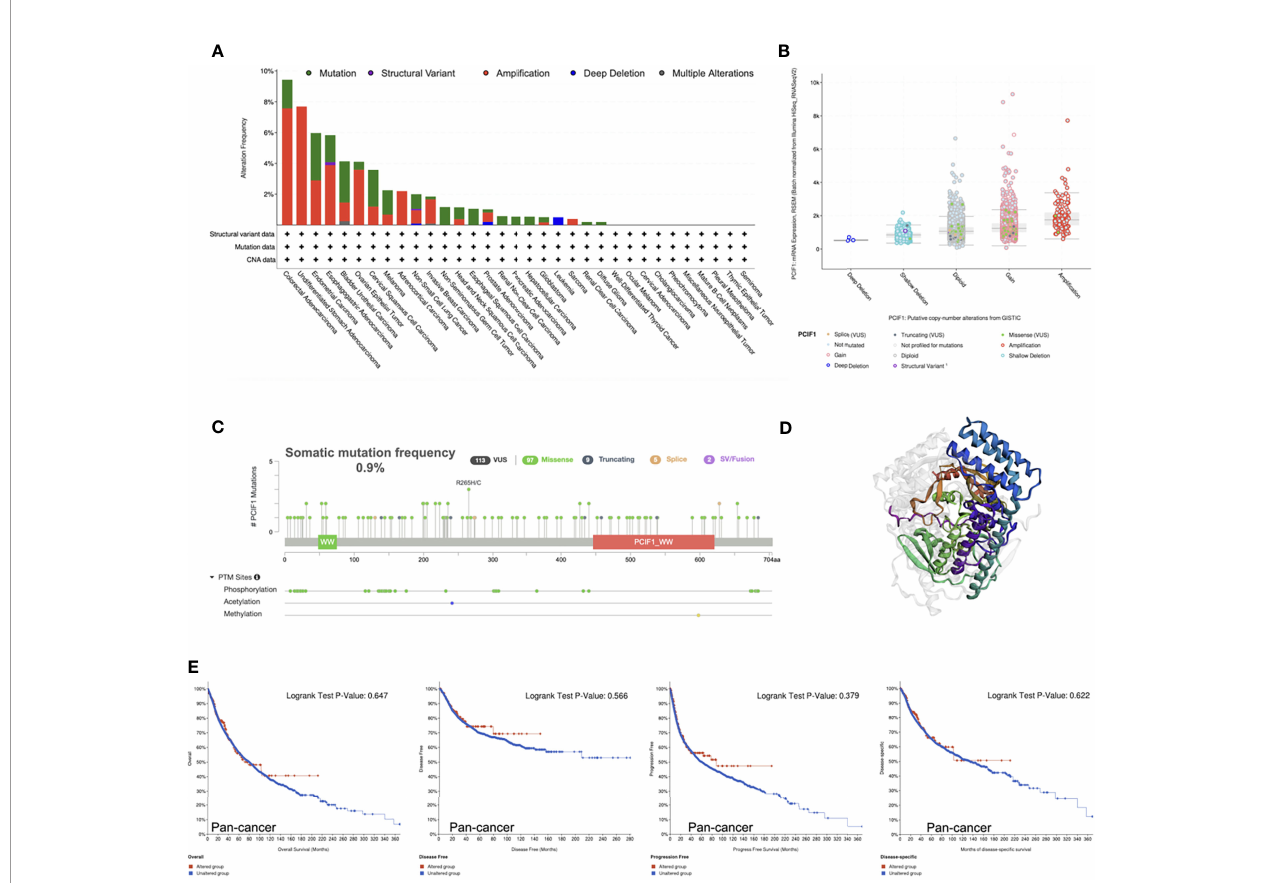
FIGURE 3 | Mutation characteristics of PCIF1 obtained from the cBioPortal website. (A) Mutation type and frequency of PCIF1. (B) Putative copy-number alterations of PCIF1. (C) Mutation frequency and posttranslational modi fi cation sites of PCIF1. (D) Three-dimensional structure of PCIF1. (E) Correlation of PCIF1 mutation and overall, disease-free, progression-free, and disease-speci fi c survival in